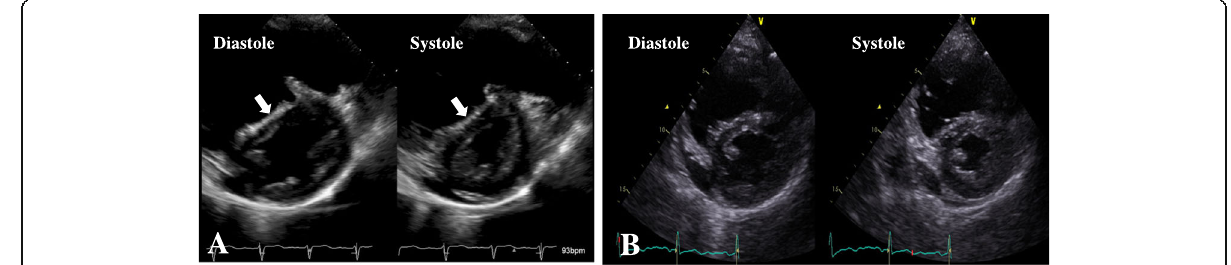
Fig. 1 Transthoracic echocardiography before ( a ) and after ( b ) balloon pulmonary angioplasty. Flattening interventricular septum (arrow) was improved after balloon pulmonary angioplasty